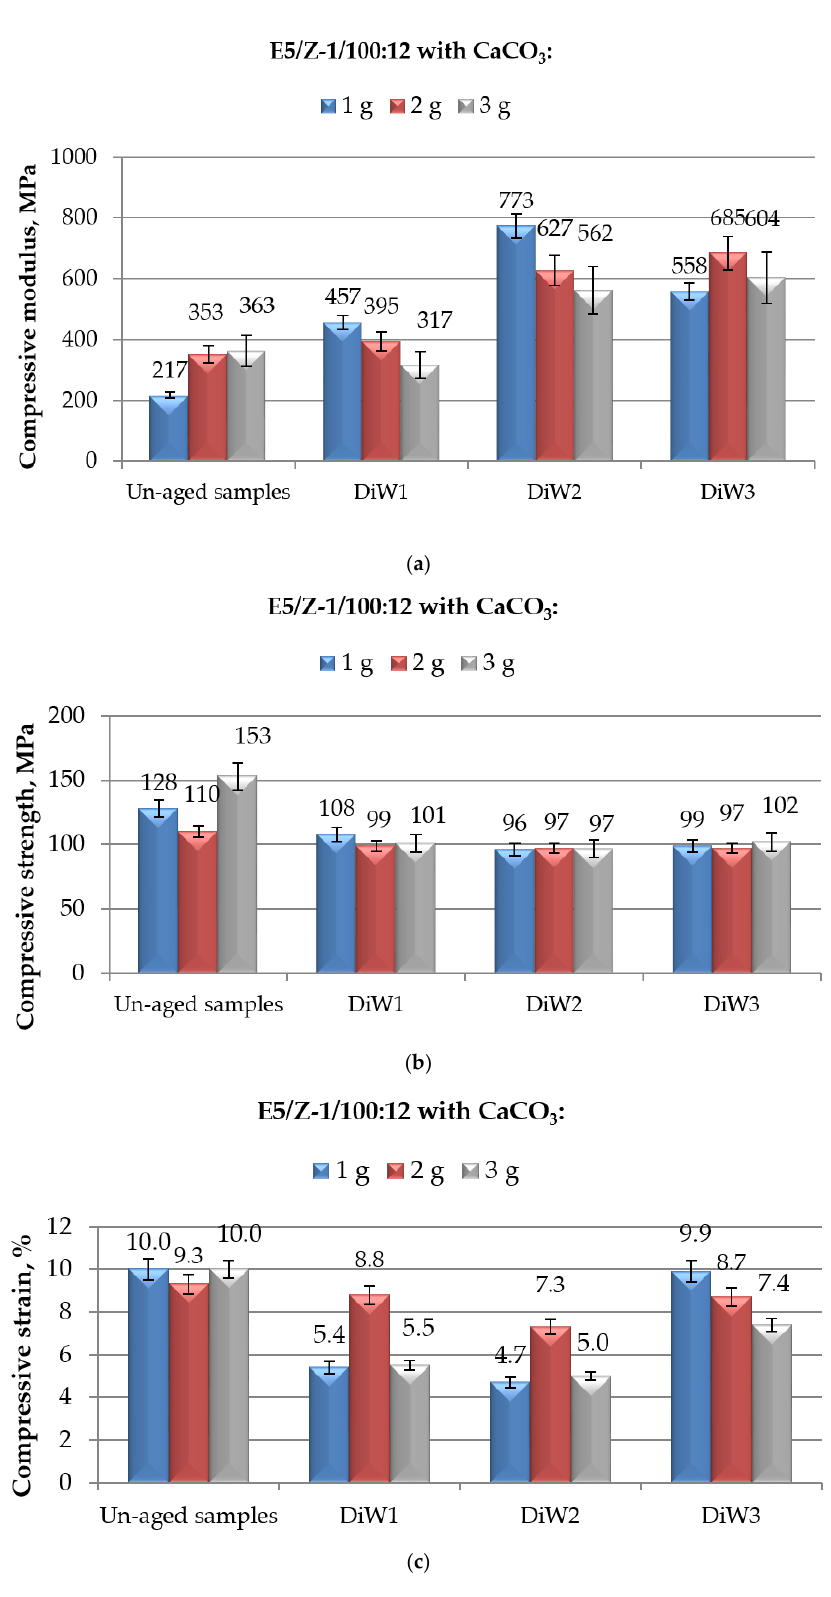
Figure 7. Results of mechanical (in compression mode) tests performed on E5/Z-1/100:12 epoxy compounds filled with different amounts of CaCO 3 and aged for different time spans (from 1 to 10 months) in distilled water: ( a ) compressive modulus; ( b ) compressive maximum strength; and ( c ) compressive strain at